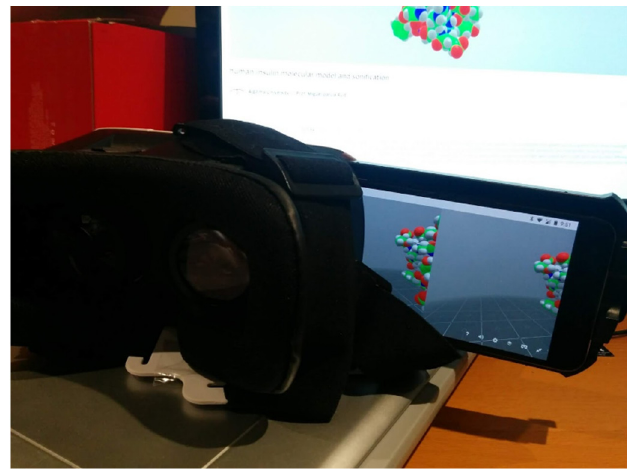
Figure 4. A VR headset displaying a molecular model using Sketchfab.